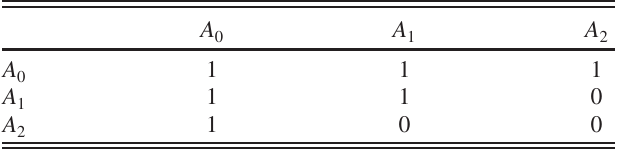
TABLE I. The interaction b ð A formation of a bond by the pair A “ 0 ” denotes the absence of a bond.